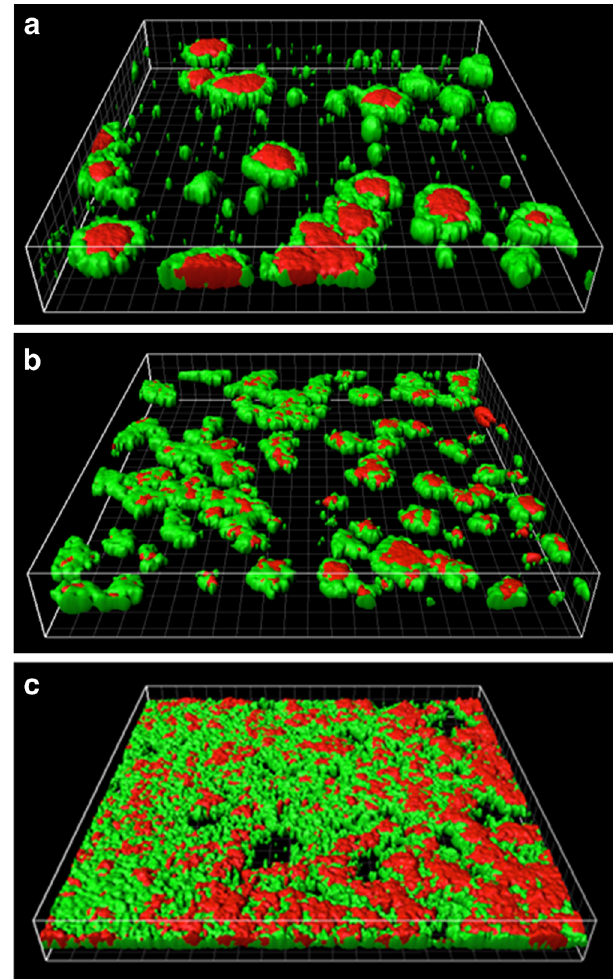
Fig. 1 CLSM images of different bio fi lms formed by cellulose variants of V. fi scheri : a no cellulose, b wild-type, and c increased cellulose. The green and red spots represents regions with relatively greater concentrations of live or dead cells, respectively. The fi gures are perspective views of a 450 × 450 µm membrane